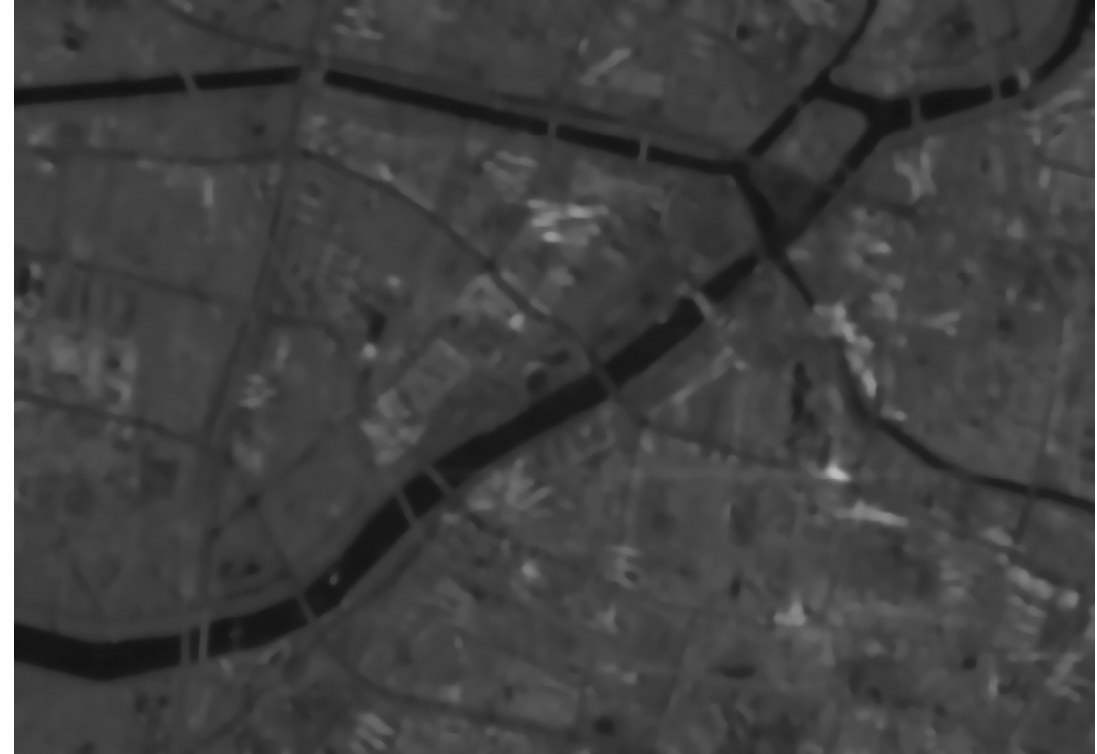
Figure 10. SRAD filtering result of the entire